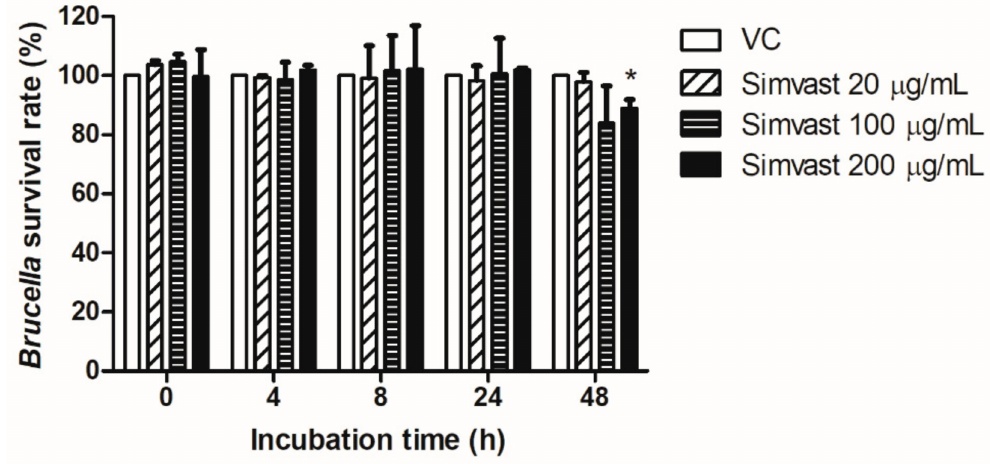
Figure 4. The effect of simvastatin on the direct growth of B. abortus was incubated with different concentrations of simvastatin for 0, 4, 8, 24, and 48 h. The data are represented as the mean ± SD of the mean of each group. Asterisks indicate statistically significant differences (* p <